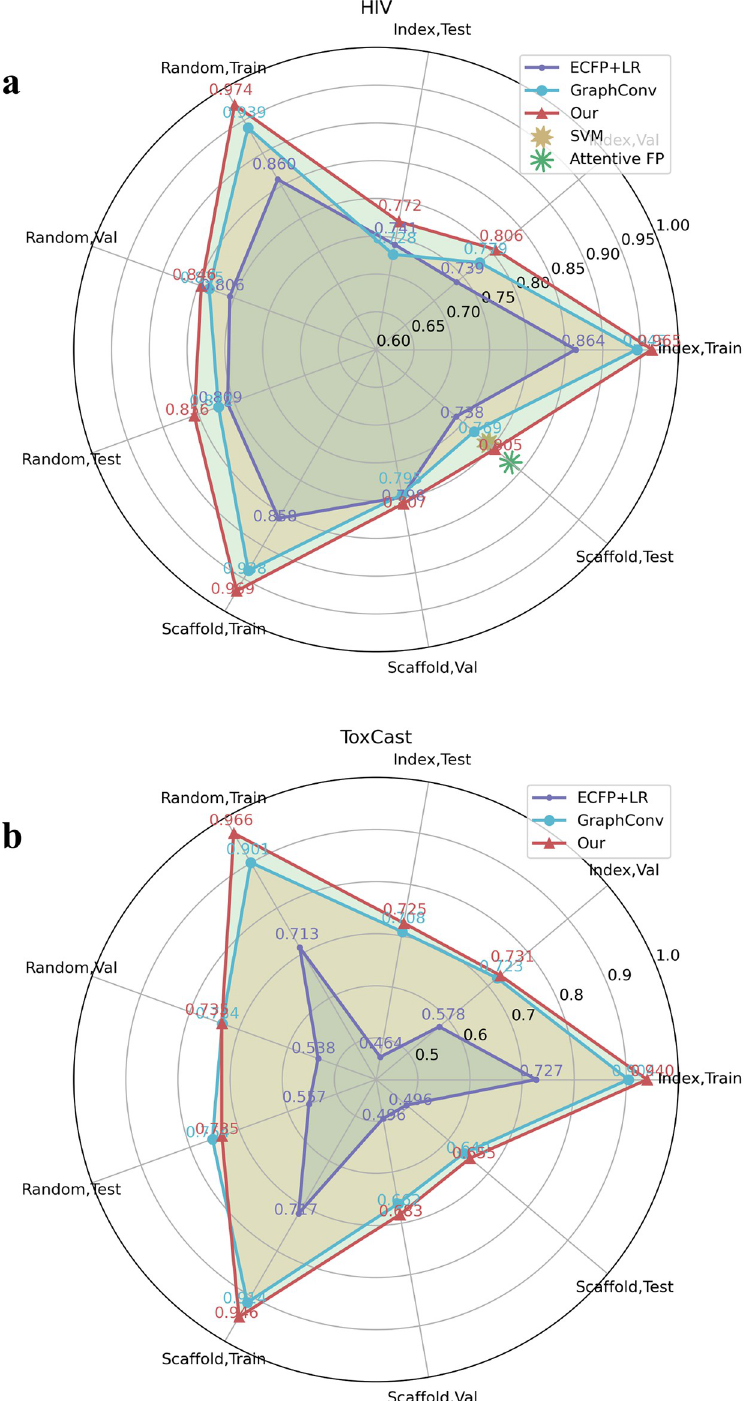
Fig 7. Performance comparison between our model and the baseline model in multitask classification tasks. The area under the curve (AUC) of the ROC curve of various models in the a HIV and b Toxcast datasets.